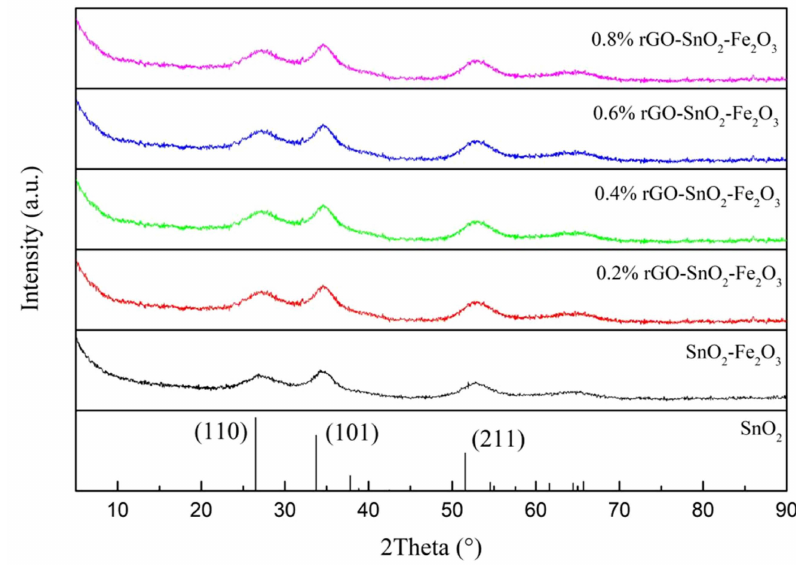
Figure 2. XRD patterns of rGO-SnO 2 -Fe 2 O 3